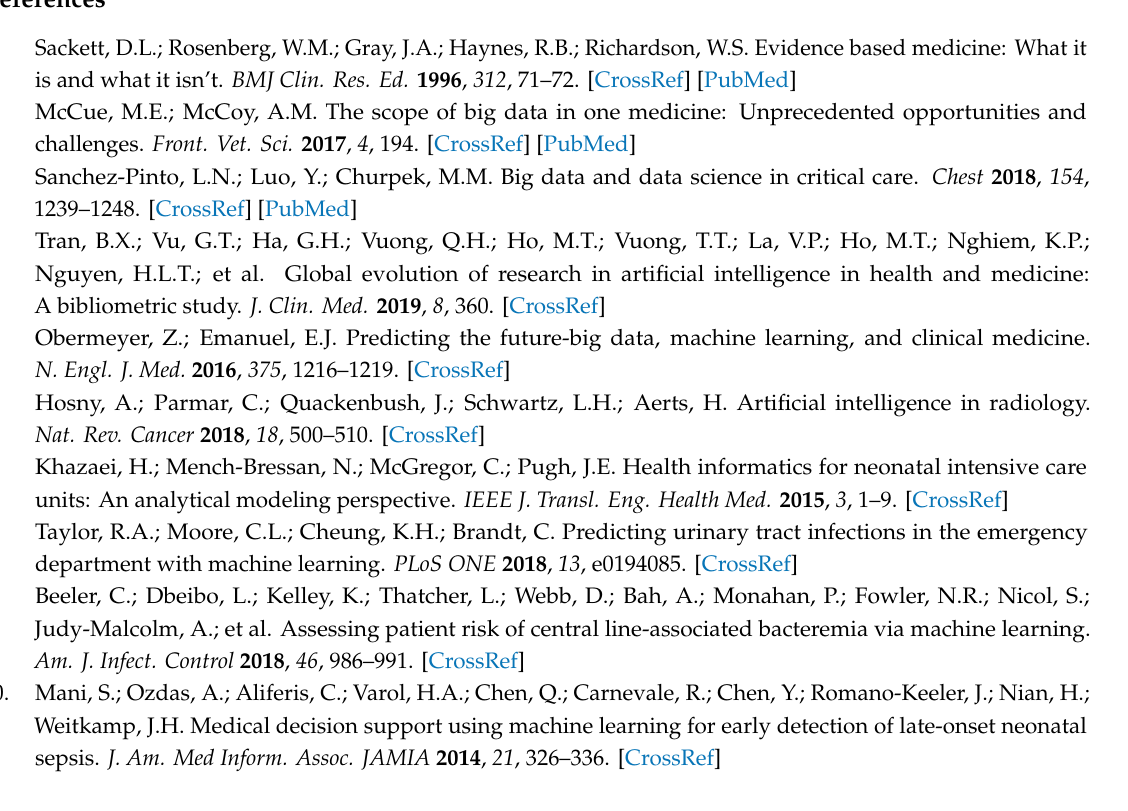
Table S1: Influence of the ranking of clinical variables on bacteremia